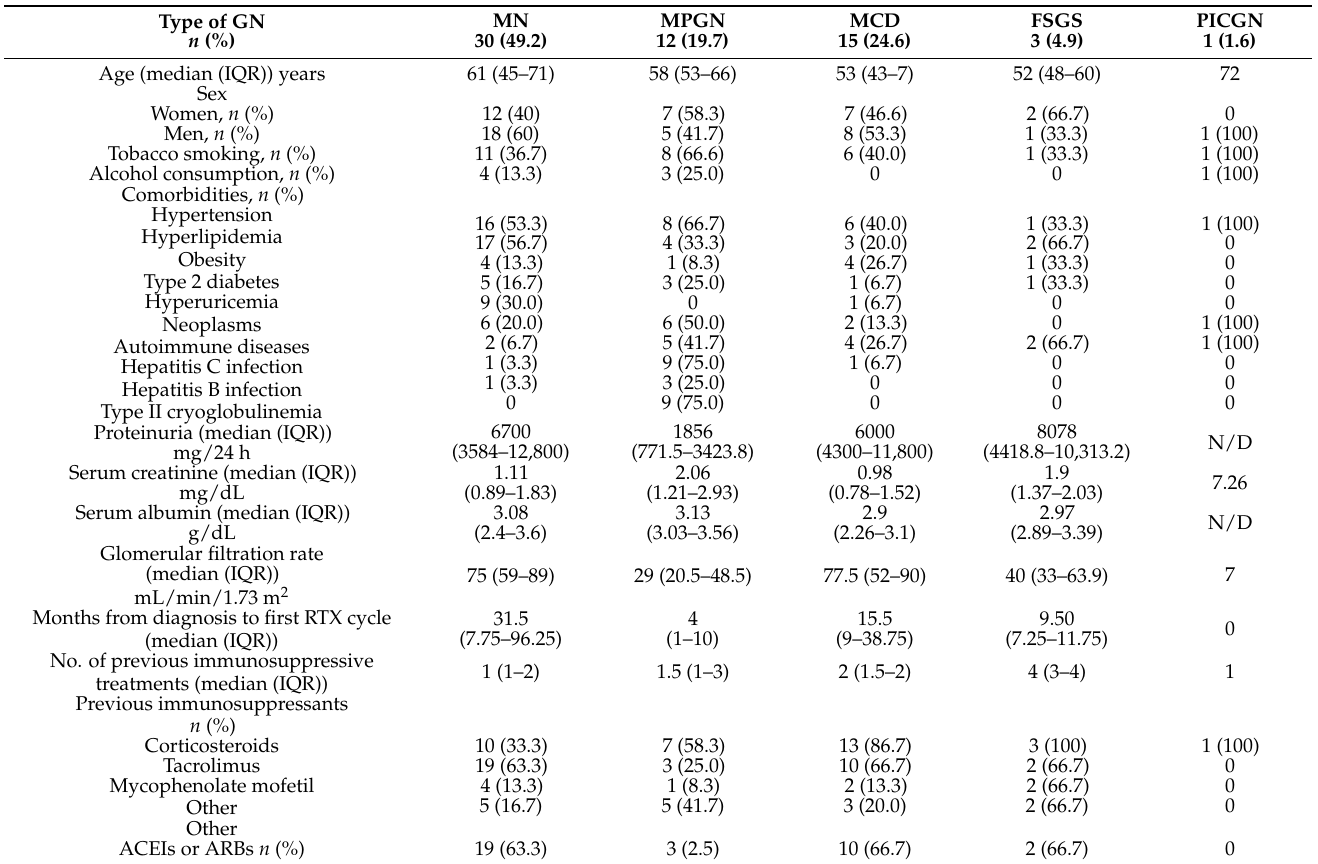
Table 1. Baseline clinical characteristics of